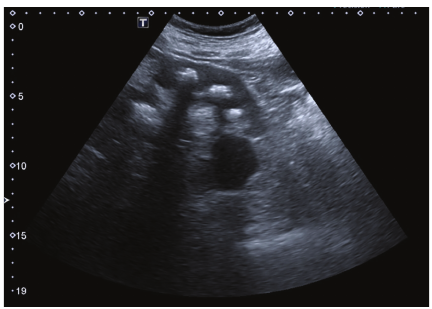
Figure 1: Multiple hyperechoic elements with shadow back.